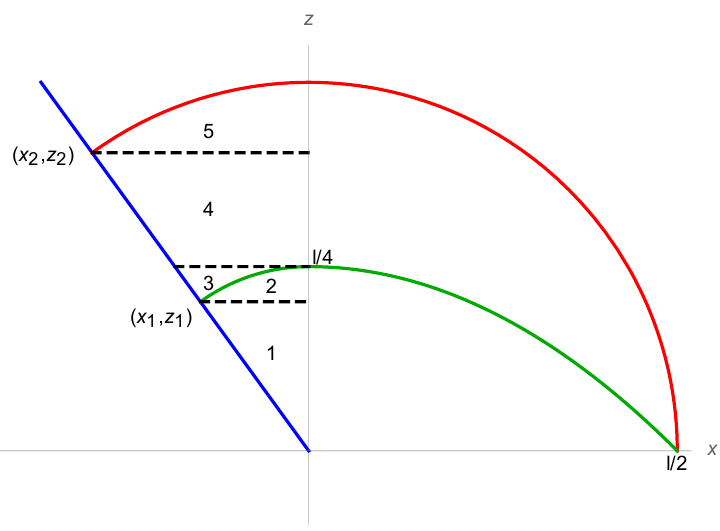
Figure 7 . Projection on the ( x, z ) plane of the integration domain. It corresponds to figure 6 seen from above (where for “above” we mean large positive t ). The end-of-the-world brane is shown in blue and the RT surface is drawn in red. The intersection curve in eqs. (4.9) and (4.10) is shown in green. The splitting of integration in eq. (4.18) for the bulk term for α ≥ π/ 6 is also shown. The integrals I 1 correspond to the regions 1 , . . . , 5 , . . . , I 5 B ,L B ,L